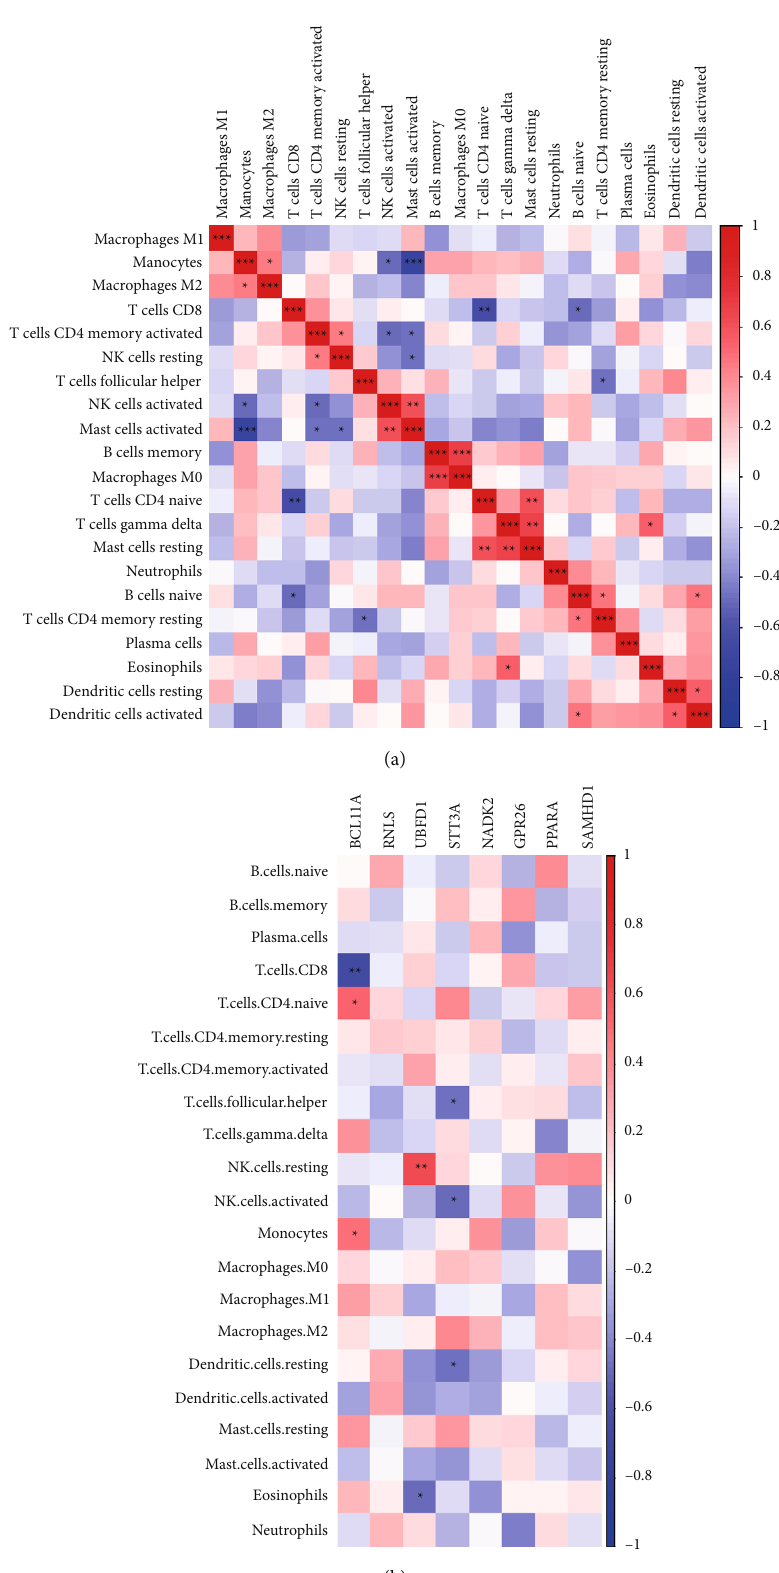
Figure 7: Correlation analysis of immune cells in the peripheral bloods of IS. (a) The correlation between immune cells in IS samples. (b) The correlation between the eight key genes and immune cells. * P < 0 : 05 , ** P < 0 : 01 , *** P < 0 : 001